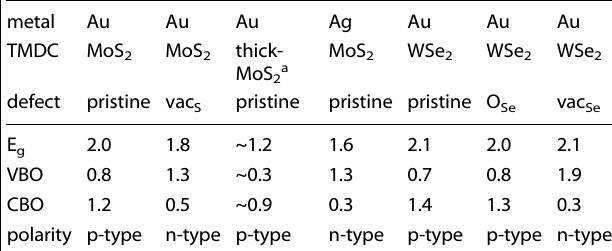
Fig. 1 Band structures of pristine TMDC/metal junctions. a MoS 2 /Au and ( b ) MoS 2 /Ag, with projection onto Mo/S orbitals plotted as coloured circles. The size of the circles is proportional to the weight of the orbital projection. The DFT valence band offsets (VBO) and conduction band offsets (CBO) are indicated. The quasiparticle (QP) VBO and CBO, obtained from separate GW calculations, are also indicated. Energies are referenced to the Fermi level, E F . Atomic structures are shown as insets: Au (gold); Ag (silver); Mo (purple); S (yellow). Table 1. Band gaps and band offsets of TMDC/metal junctions. Quasiparticle (QP) band gap (E g ) of the TMDC, the valence band offset (VBO) and the conduction band offset (CBO) for the systems reported in the main